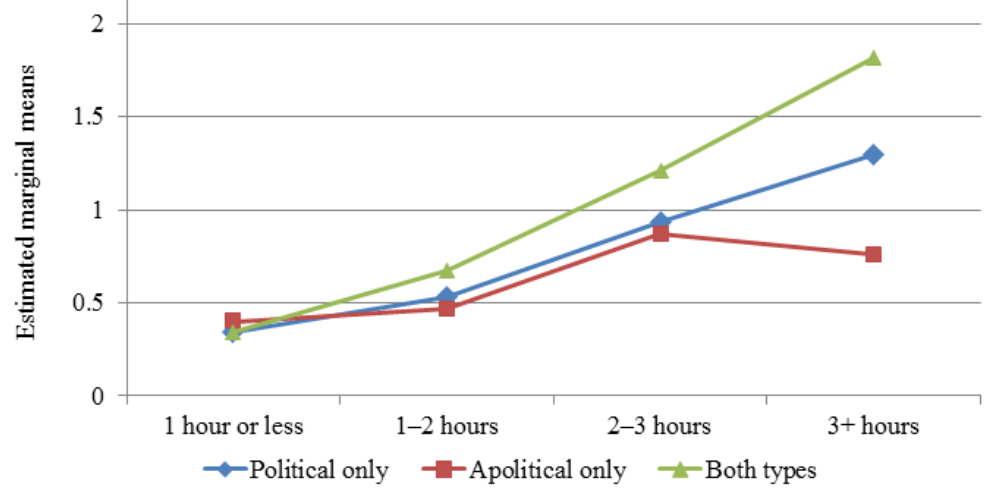
Figure 2 . Relationships between types of content binge ‐ watched, frequency of streaming television and Figure 2. Relationships between types of content binge-watched, frequency of streaming television online political participation. and online political participation. Soc. Sci. 2016 , 5 , 65